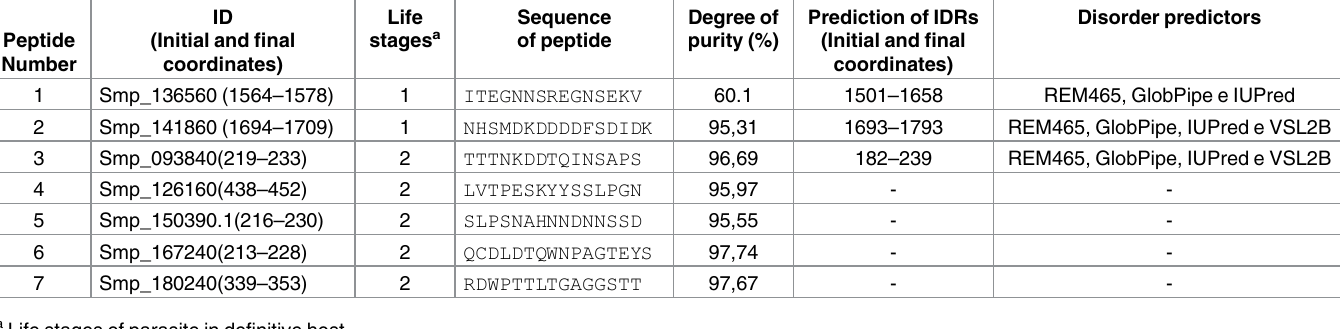
Seven peptides (one for each selected protein), with no similarity host or other heelminths’ proteins, were chosen to be used as antigens in the serological tests. Peptide number, protein ID (systematic name), life stages in which they are expressed, peptide sequence, degree of purity, prediction of IDRs and disorder predictors for each selected peptide are described in Table 2. Three of the peptides having predicted IDRs in their neighborhood were selected. These synthetically produced peptides were employed in ELISA tests against human sera from the following experimental groups: HD, NEG, INF, 30DPT and 180DPT, as described in the Materials and Methods section. Significant IgG reativity against peptides 1, 3, 4, 5 and 7 were observed in the group of S . mansoni infected individuals in comparison with healthy donor. Significant IgG levels against peptides 1, 3, 4, and 5 were also observed in infected group when compared to individuals from the endemic area with negative stool examination (Fig 2). A significant reduction in serum reactivity to peptide 5 was observed in the groups 30DPT and 180DPT (Fig 2). Reactivity to peptide 7 was still observed in sera from the 180 days post-treatment group. Paired analysis before and after treatment were performed for some individuals. Data demonstrate that a significant descrease in IgG levels against peptides 1, 3 and 5 is observed 30 and 180 days post-treatment. Decreased IgG levels against peptides 2 and 4 were also observed 30 and 180 days post-treatment, respectivelly (S1 Fig). Table 2. Epitopes selected to be used as synthetic peptides in ELISA